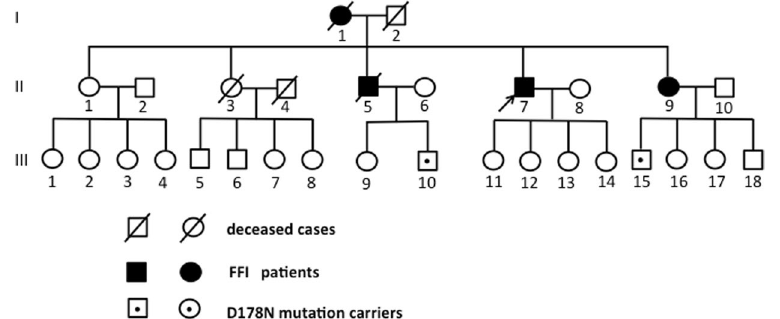
Figure 1. The pedigree of case 1(II-7) and case 2(II-9). II-7 is the proband of this pedigree (arrow). II-7 and II-9 are respectively Patient 1 and Patient 2 who carried PRNP D178N mutation. Additionally, seven family members were screened for PRNP gene mutation: II-6, III-6, III-11, III-13, and III-14 were healthy participant free of PRNP D178N mutation; III-10 and III-15 were clinically healthy carriers of the PRNP D178N mutation. Other family members were not screened due to lack of consent or prior death.